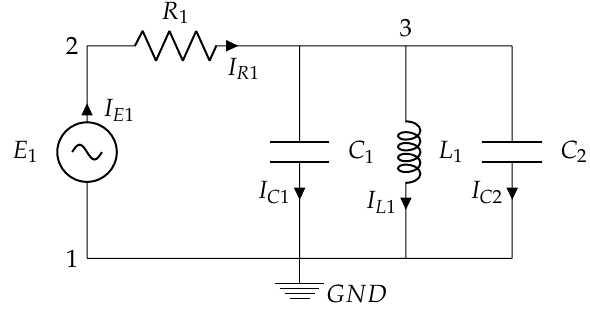
Figure 1. Diagram of an RLC circuit with constant coefficients.